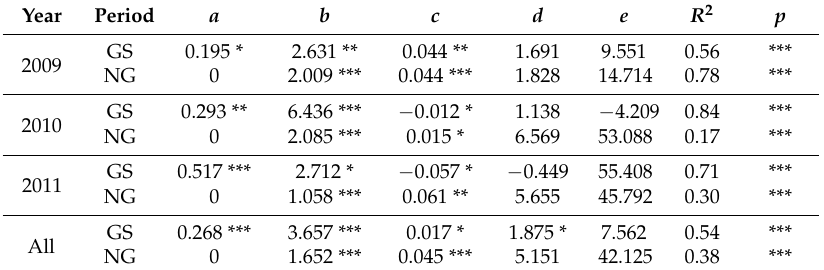
Table 1. Regression parameters for the satellite-based ecosystem repiration (Re) estimations based on tower-based gross primary production (GPP) and Re measurements (Equation